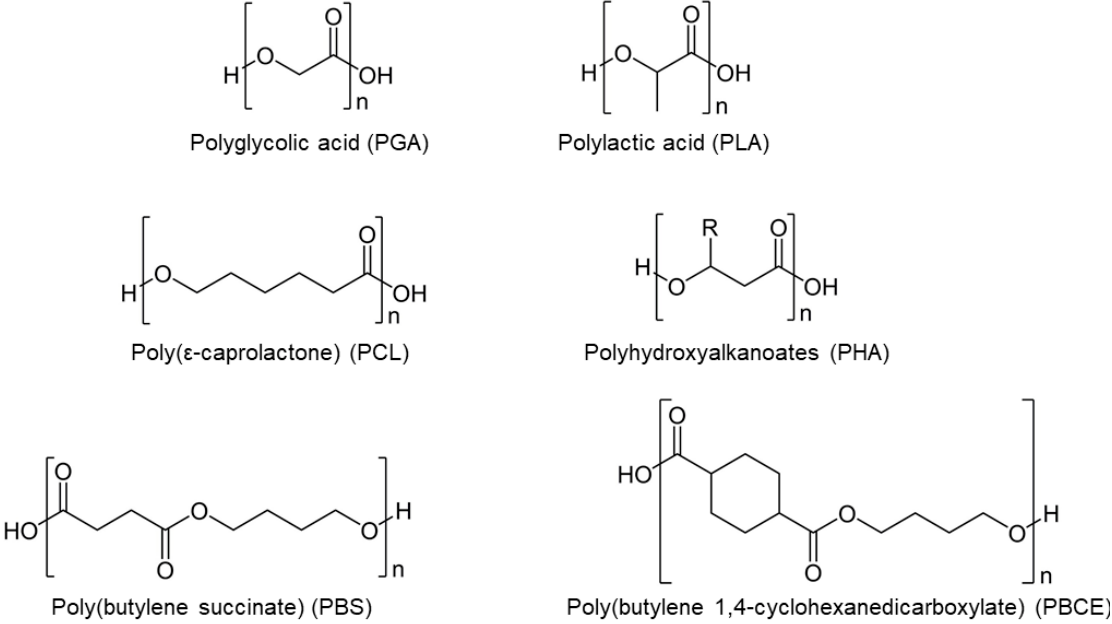
Figure 1. Chemical structure of aliphatic polyesters (APs) used for biomedical applications.